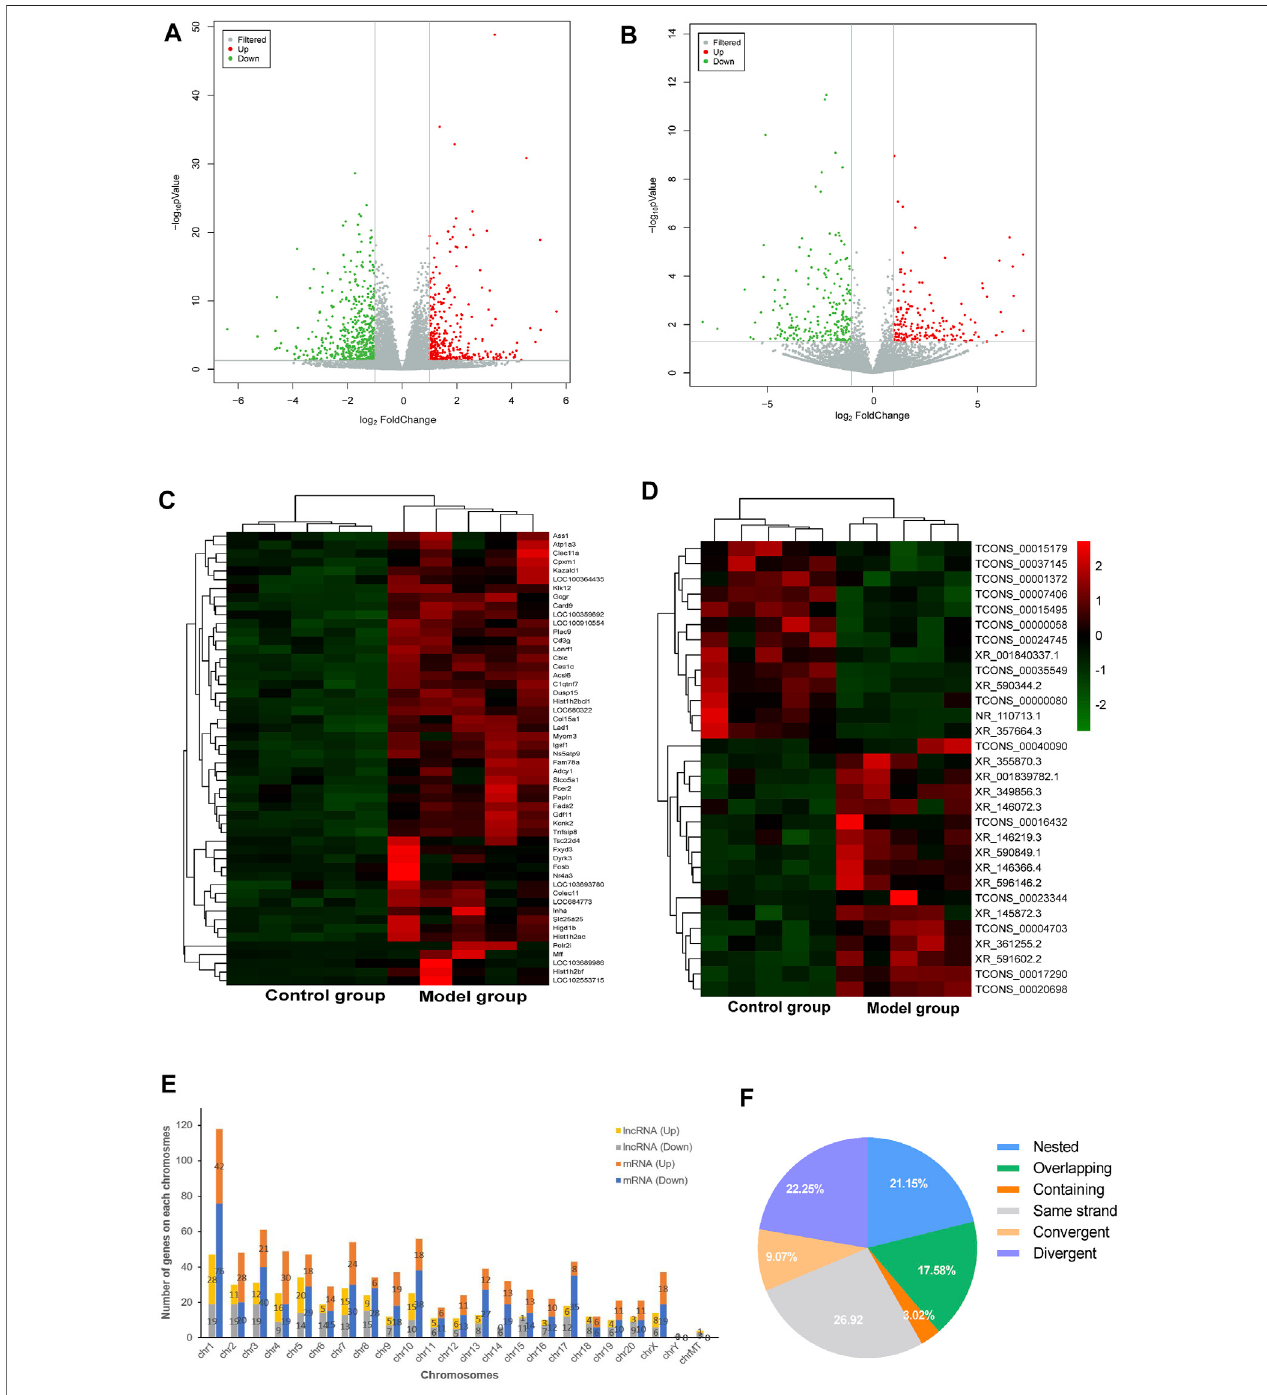
FIGURE 2 | LncRNA and mRNA expression pro fi le of the rat myocardium. (A , B) Volcano plots show DE-mRNAs (A) and lncRNAs (B) in the two groups. The red and green points represent up- and downregulated mRNAs/lncRNAs (compare to the control group), respectively. The horizontal green line depicts * p < 0.05, whereas the vertical green line shows a two-fold change in up and downregulation. (C , D) Hierarchical clustering analysis presents differentially expressed mRNAs (C) and lncRNAs (D) and red and green represent up- and down regulated mRNAs/lncRNAs with ≥ two-fold changed, respectively (3 < FPKM < 50). (E) Chromosomal distribution of deregulated mRNAs and lncRNAs. (F) Intergenic lncRNAs included convergent, divergent, and same strand accounting for 58% and genic lncRNAs included containing, nested, and overlapping were accounted for 42%.